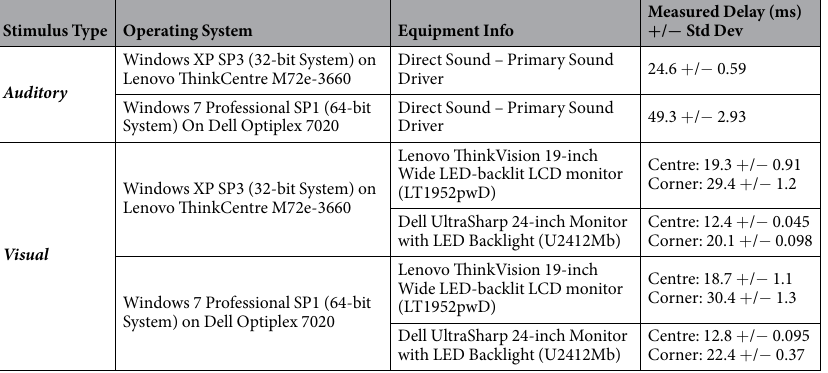
Table 1. The Time Delays in Event-Related Potential Studies Associated with an Auditory or Visual Stimulus over Different Operating Systems and Hardware